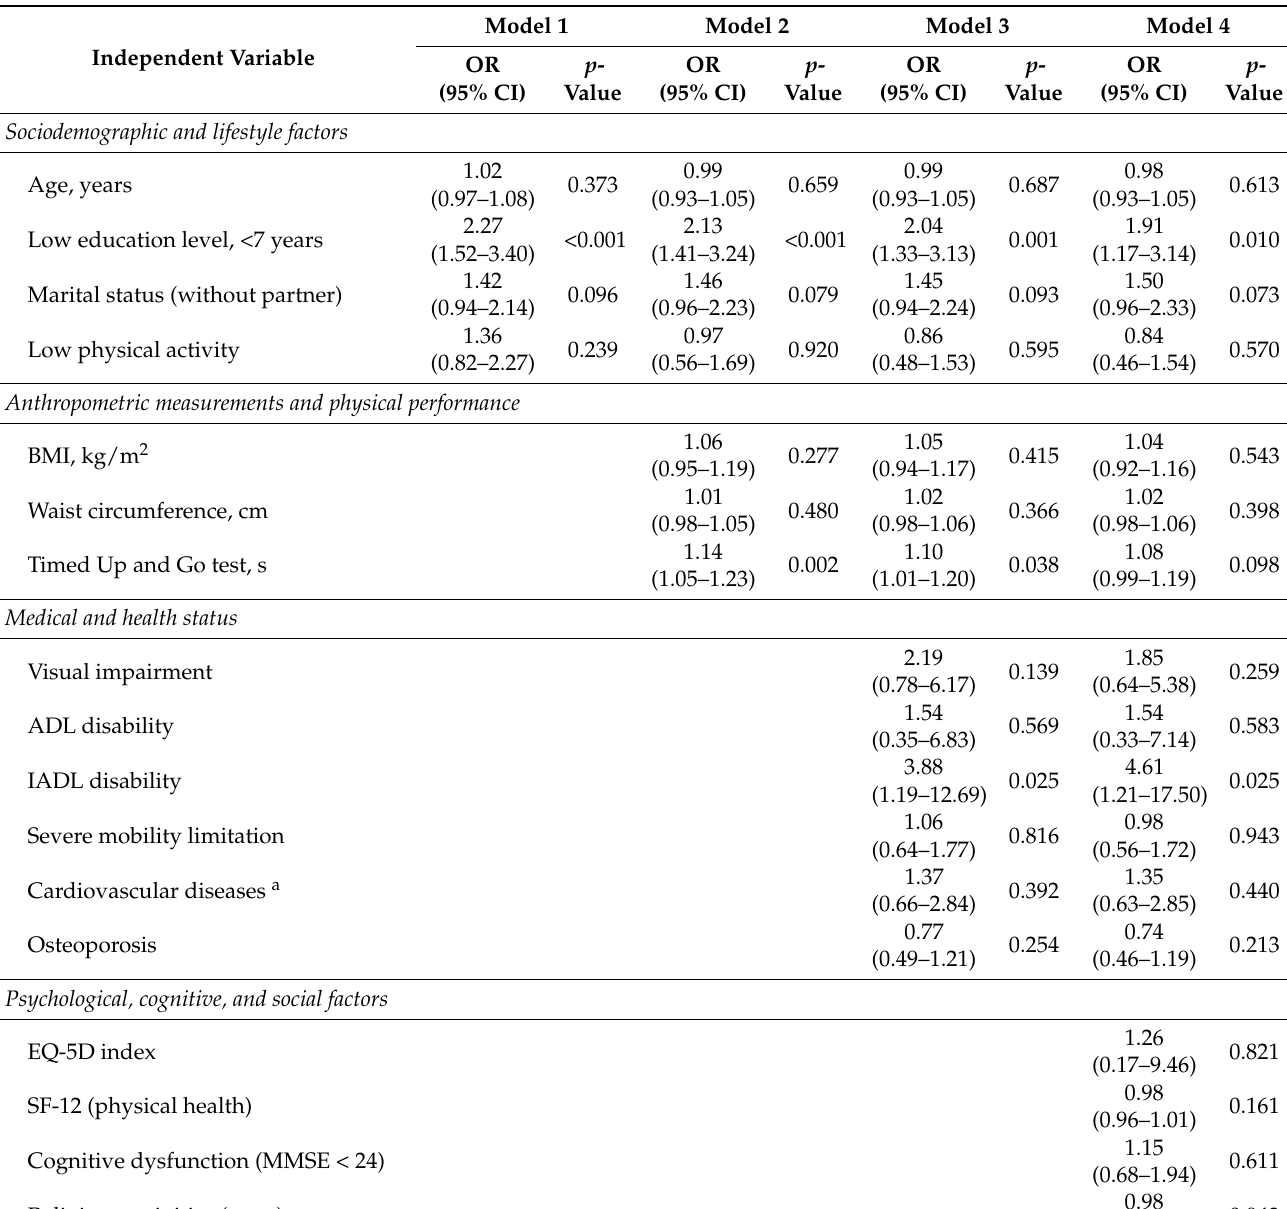
Table 3. Adjusted odds ratios of variables for predicting possible sarcopenia compared with sarcope- nia in